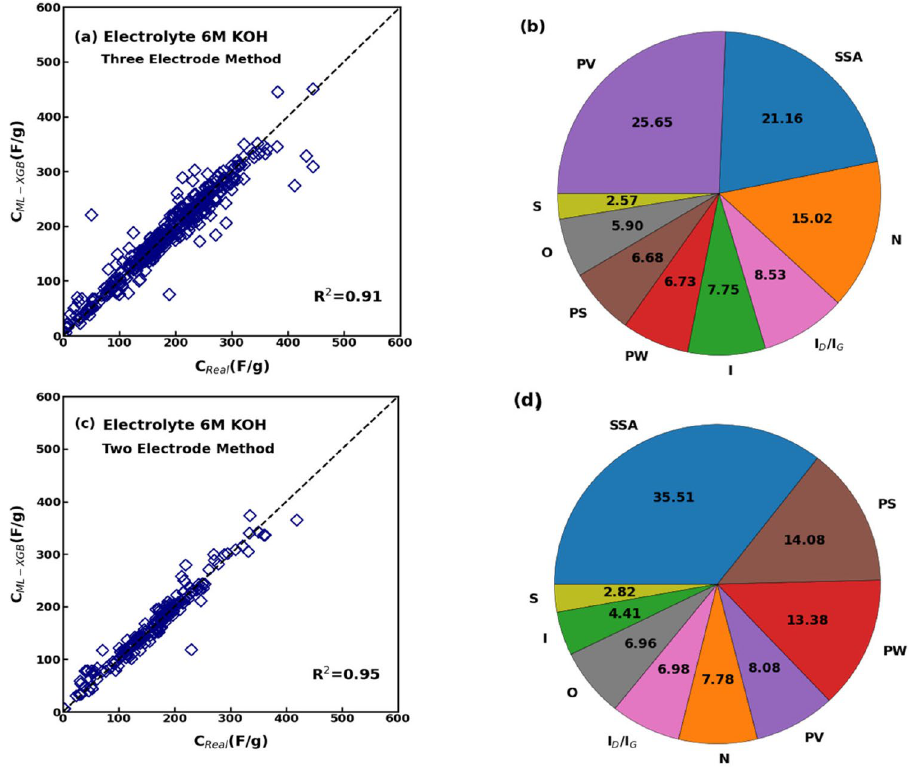
Figure 7. ( a ) Comparison between predicted and actual specific capacitance and ( b ) feature analysis for the subset of data having 6 M KOH electrolyte and measured by three-electrode method. ( c ) Comparison between predicted and actual specific capacitance and ( d ) feature analysis for the subset of data having 6 M KOH electrolyte and measured by two-electrode